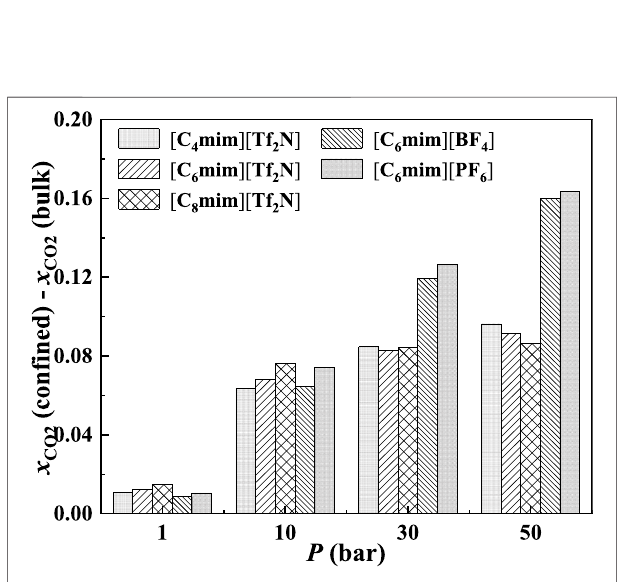
FIGURE17| CalculatedadditionalsolubilitiesofILscon fi nedin25 Åslit- shaped pore at 298.15 K and different pressures.